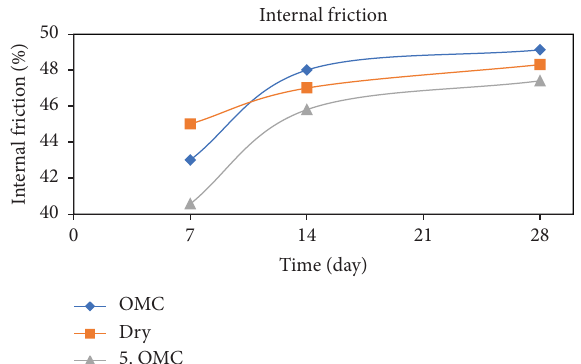
Figure 5: Relationship between the internal friction and the curing time after